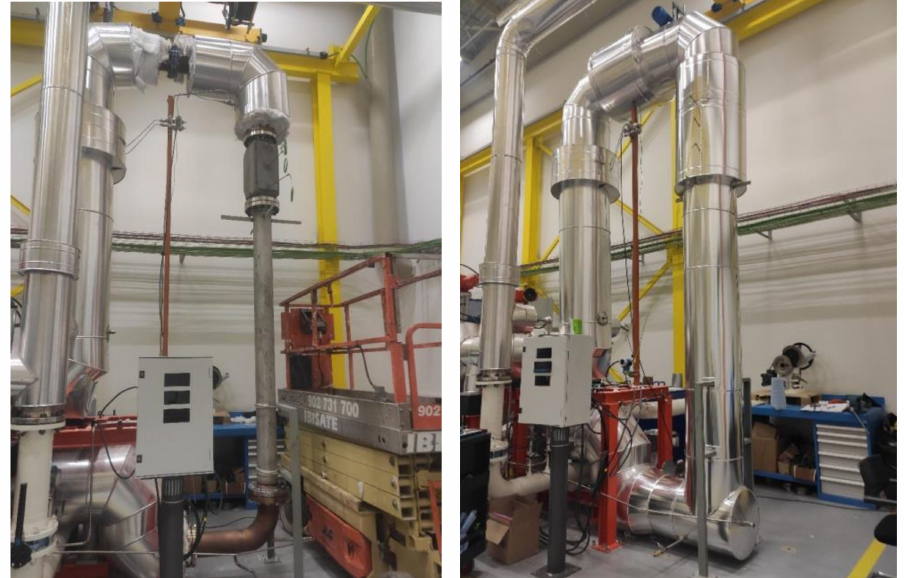
Figure 2. Thermal energy storage testing loop.